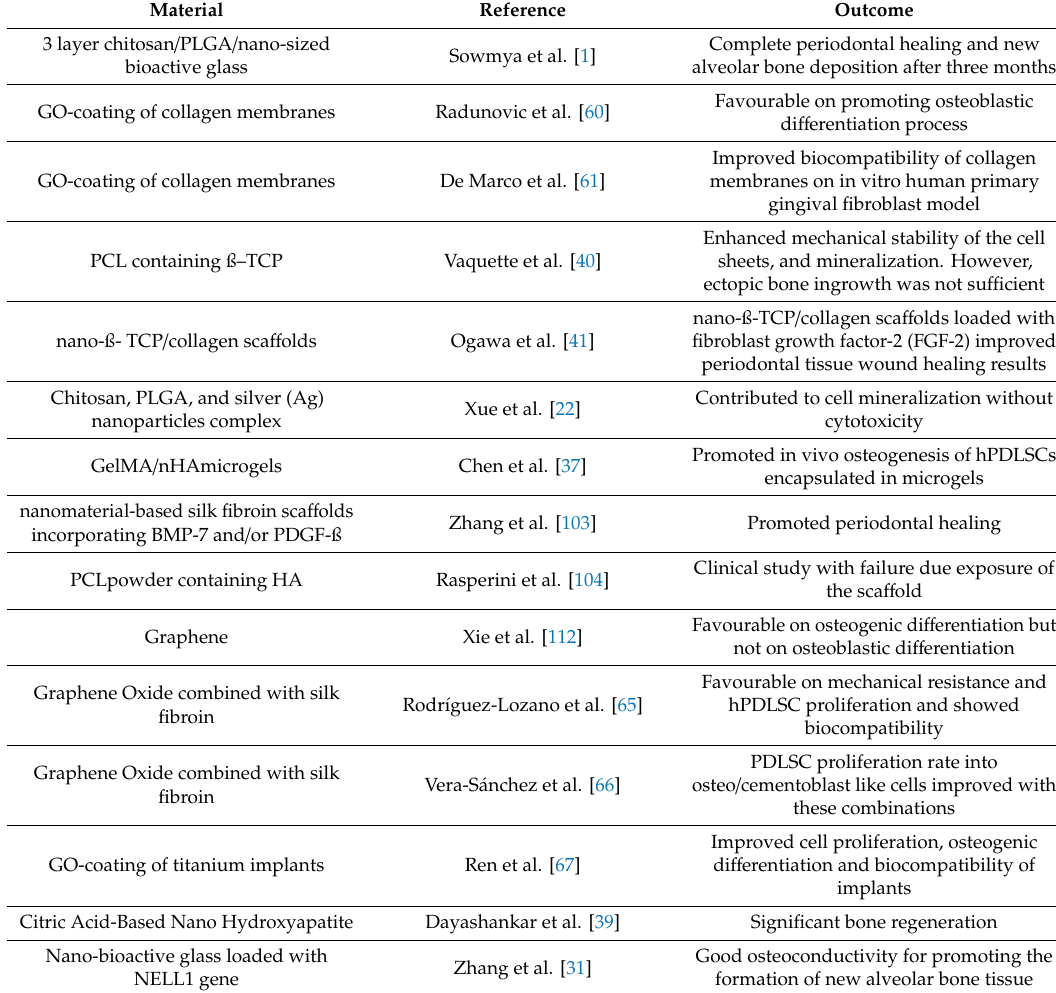
Table 1. Nanosca ff old applications for alveolar bone